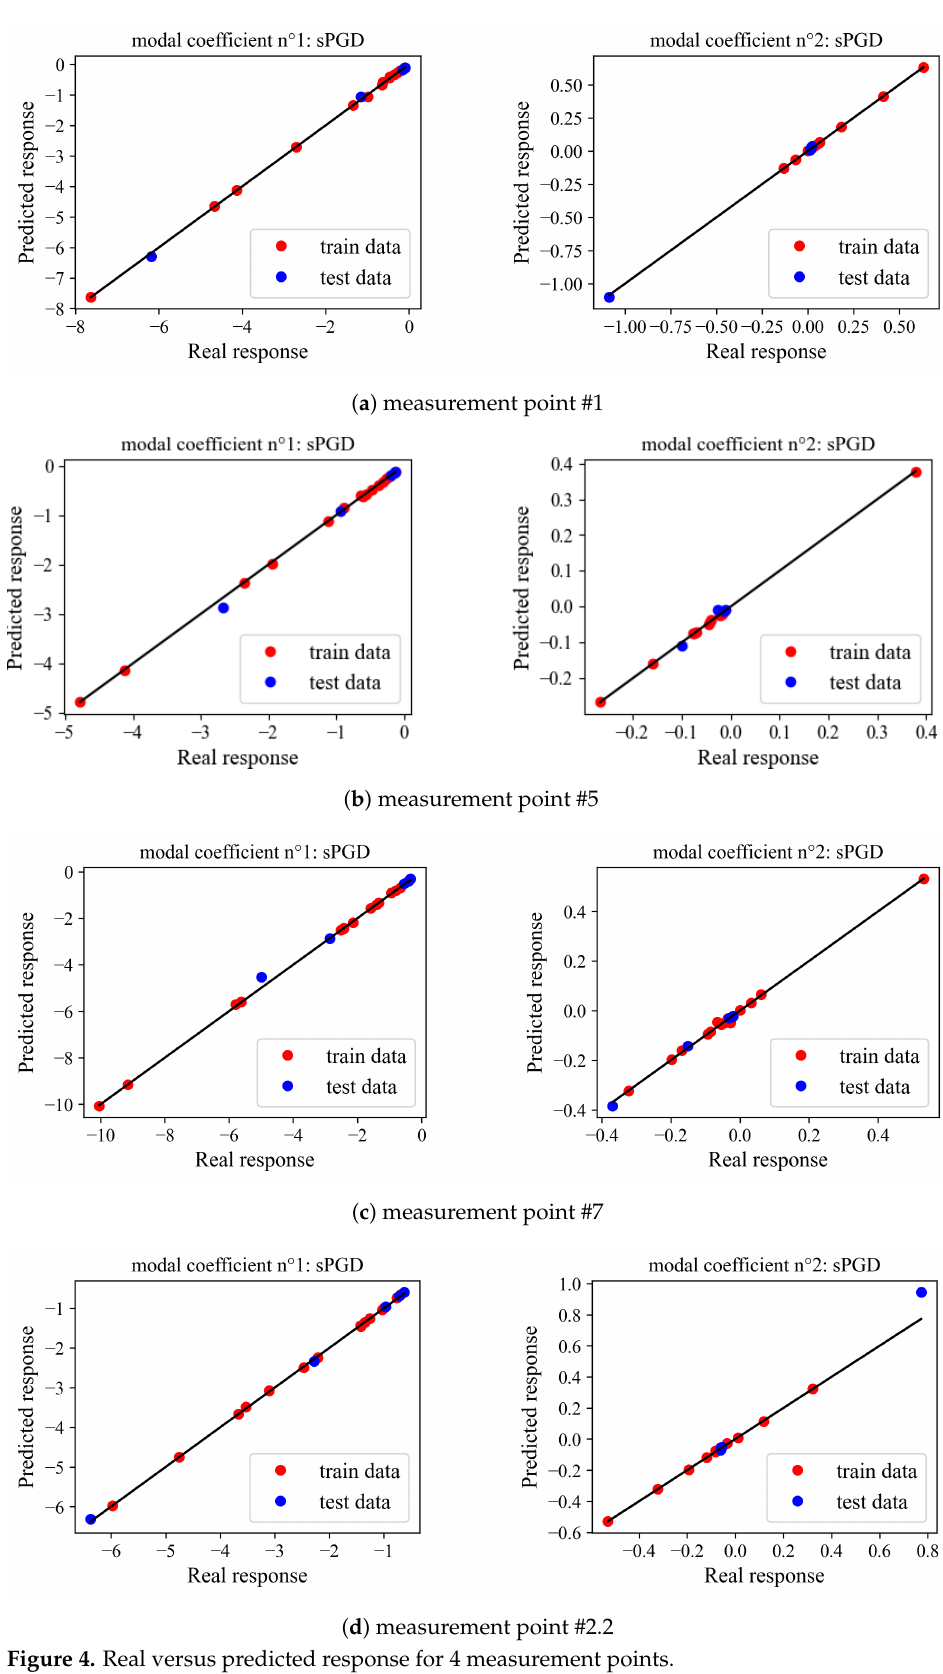
Figure 4. Real versus predicted response for 4 measurement